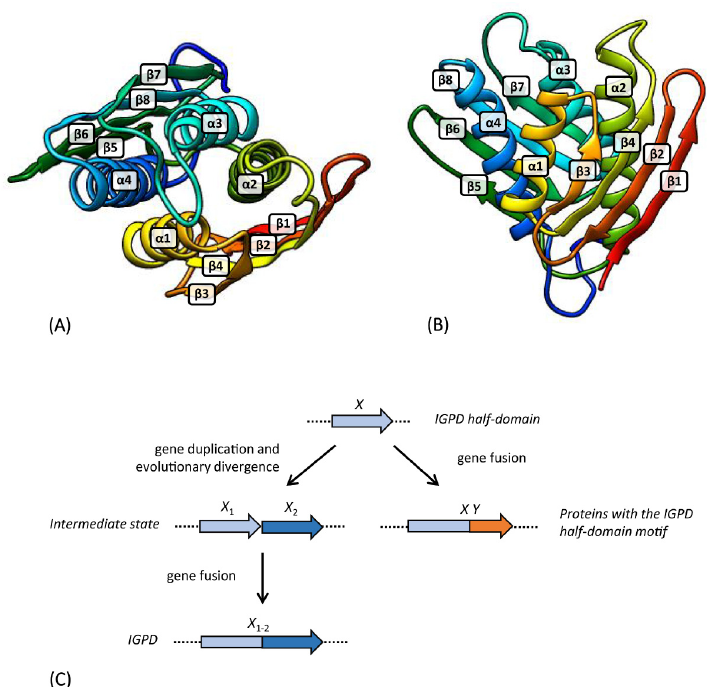
Figure 7. ( A , B ) Three-dimensional structure of IGPD domain of E. coli HisB. α -helices and β -strands are labeled. ( A ) Top view of IGPD; ( B ) side view. ( C ) Evolutionary model proposed to explain the origin and evolution of IGPD and proteins with subdomains with topologies identical to the IGPD half-domain. Microorganisms 2020 , 8 , x FOR PEER REVIEW